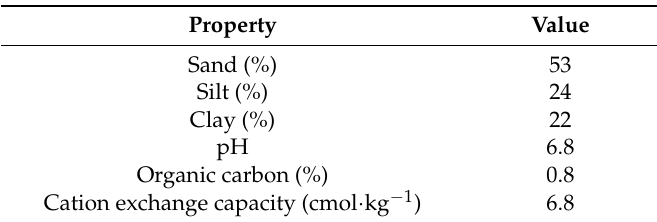
Table 1. Main properties of the